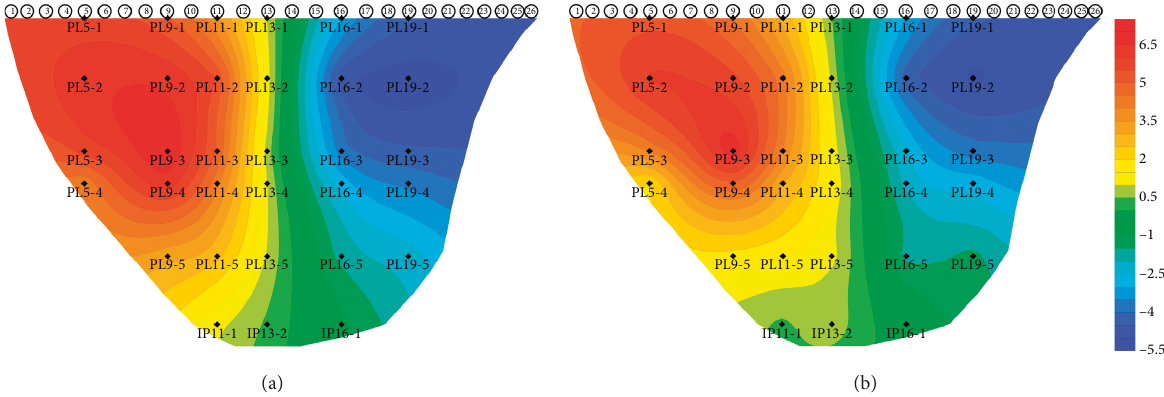
Figure 17: Comparison nephogram between the calculated tangential displacement and that of the